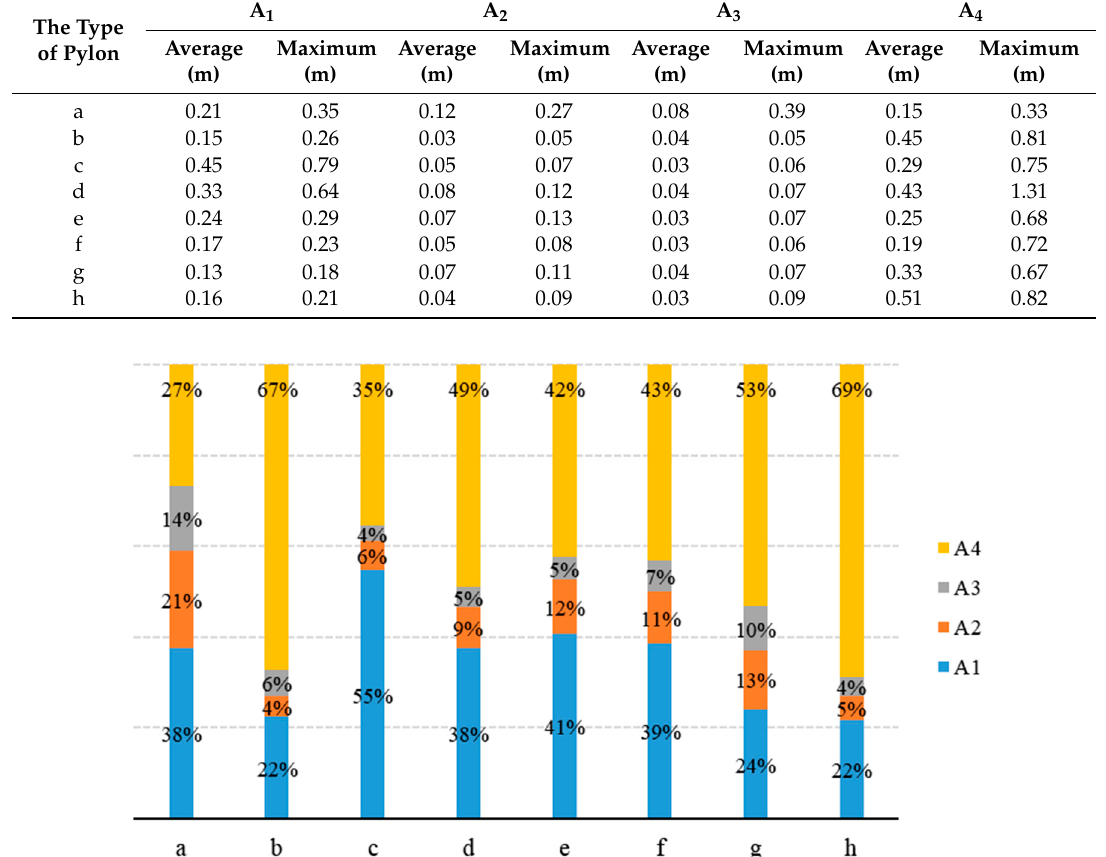
Figure 23. The proportion of four types of errors. ( a ) the proportion of four types of errors of the type-a pylon; ( b ) the proportion of four types of errors of the type-b pylon; ( c ) the proportion of four types of errors of the type-c pylon; ( d ) the proportion of four types of errors of the type-d pylon; ( e ) the proportion of four types of errors of the type-e pylon; ( f ) the proportion of four types of errors of the type-f pylon; ( g ) the proportion of four types of errors of the type-g pylon; ( h ) the proportion of four types of errors of the type-h pylon.